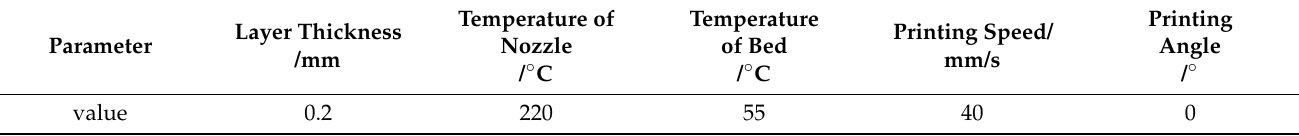
Table 4. Three-dimensional Printing Process